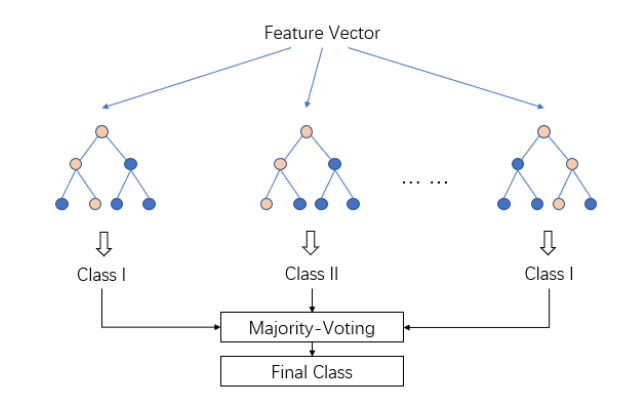
Figure 7. The structure of LightGBM model (LGB). LGB is a kind of implementation of Gradient Boosting Decision Tree that is widely used in various machine learning